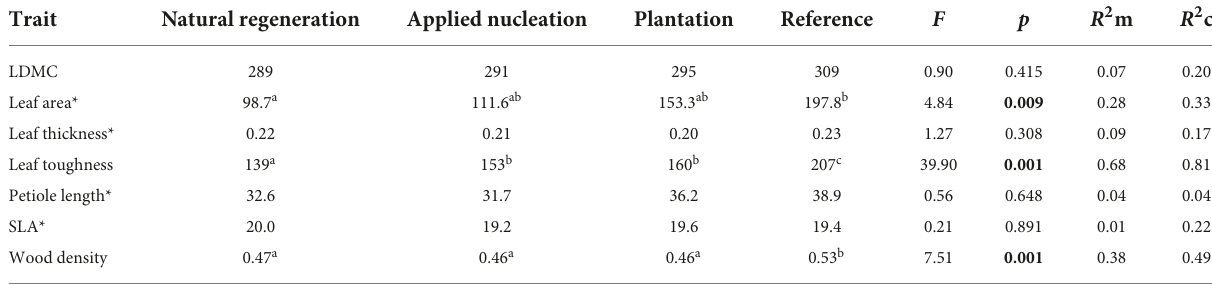
TABLE 1 Estimated marginal means (EMMs) for tree sapling functional trait community-weighted means (CWMs) in each treatment in 2019, estimated with linear mixed models. Trait Natural regeneration Applied nucleation